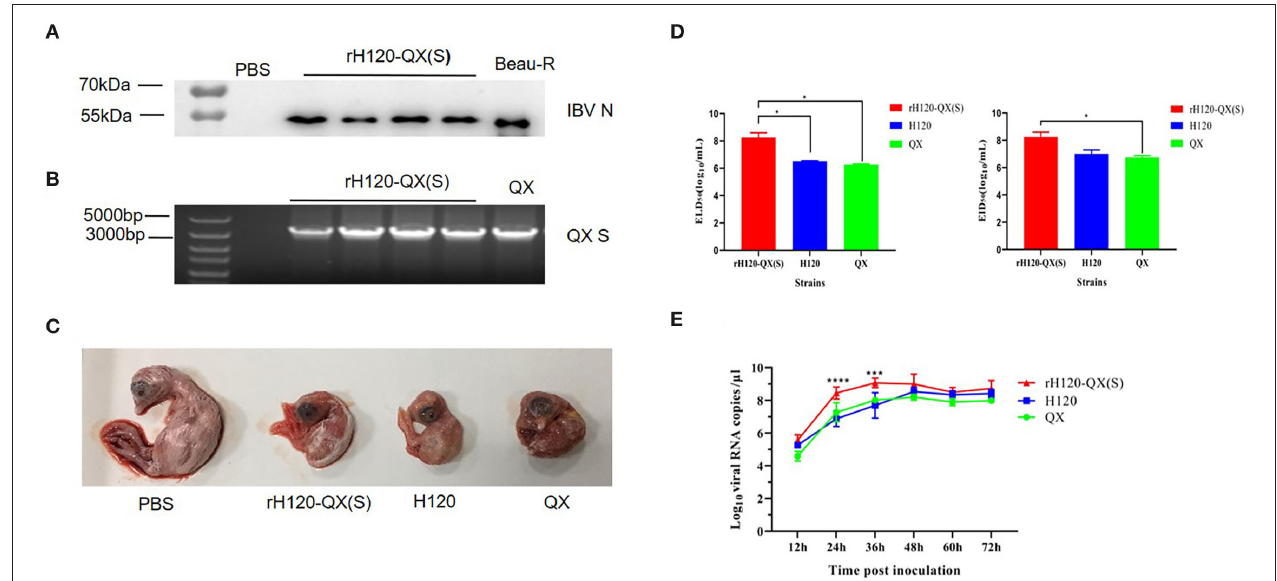
FIGURE 2 | The biological characteristics of rH120-QX(S). (A) Western blot analysis of rH120-QX(S) in fifth-generation chicken embryos. The allantoic fluid was detected with a polyclonal antibody against the IBV N protein. The Beau-R virus was loaded as a positive control. (B) RT-PCR analysis of rH120-QX(S) in the fifth-generation chicken embryo. The allantoic fluid was subjected to RNA extraction and RT-PCR by using the primers targeting the QX S gene. The QX virus included in the parallel RT-PCR experiment as a positive control. (C) Pathogenicity of rH120-QX(S), H120, and QX strains in 10-day-old SPF chicken embryos. Embryo lesions were observed at 7 d.p.i. (D) The ELD 50 and EID 50 of the rH120-QX(S), H120, and QX strains were measured in 10-day-old SPF chicken embryos. (E) The growth kinetics of the rH120-QX(S), H120, and QX in 10-day-old SPF chicken embryos. * p ≤ 0.05; *** p ≤ 0.001; **** p ≤